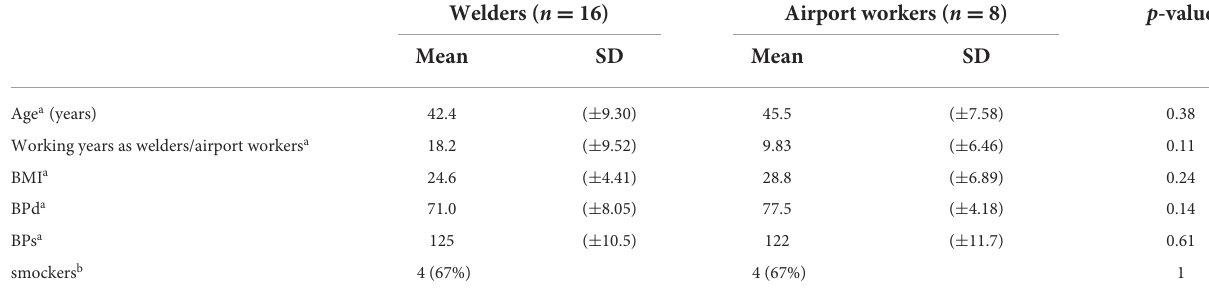
TABLE 1 Population characteristics.